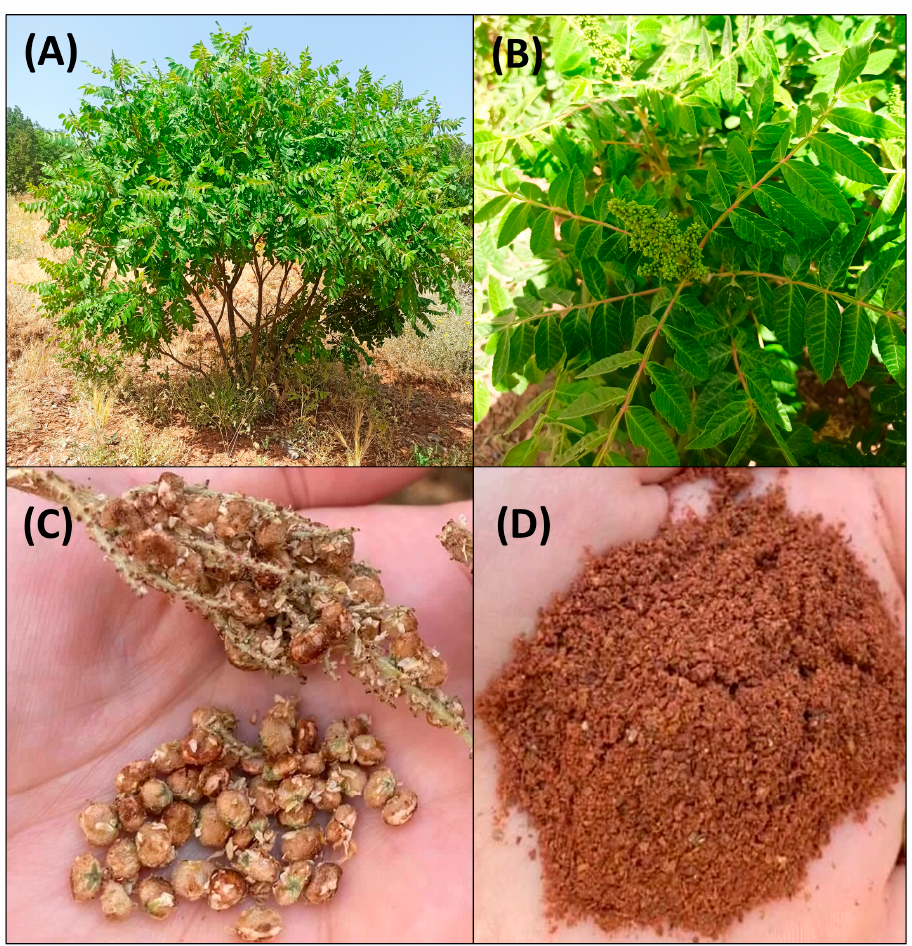
Figure 5. Rhus coriaria L. (sumac) morphology: ( A ) shrub; ( B ) leaves and immature inflorescence; ( C ) dried fruits; ( D ) powdered fruits (spice).